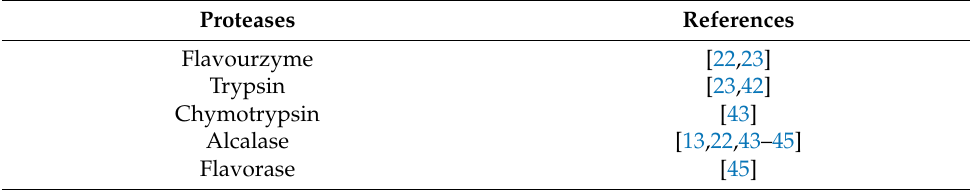
Table 1. Proteases commonly used for the production of peptide-rich hydrolysates.